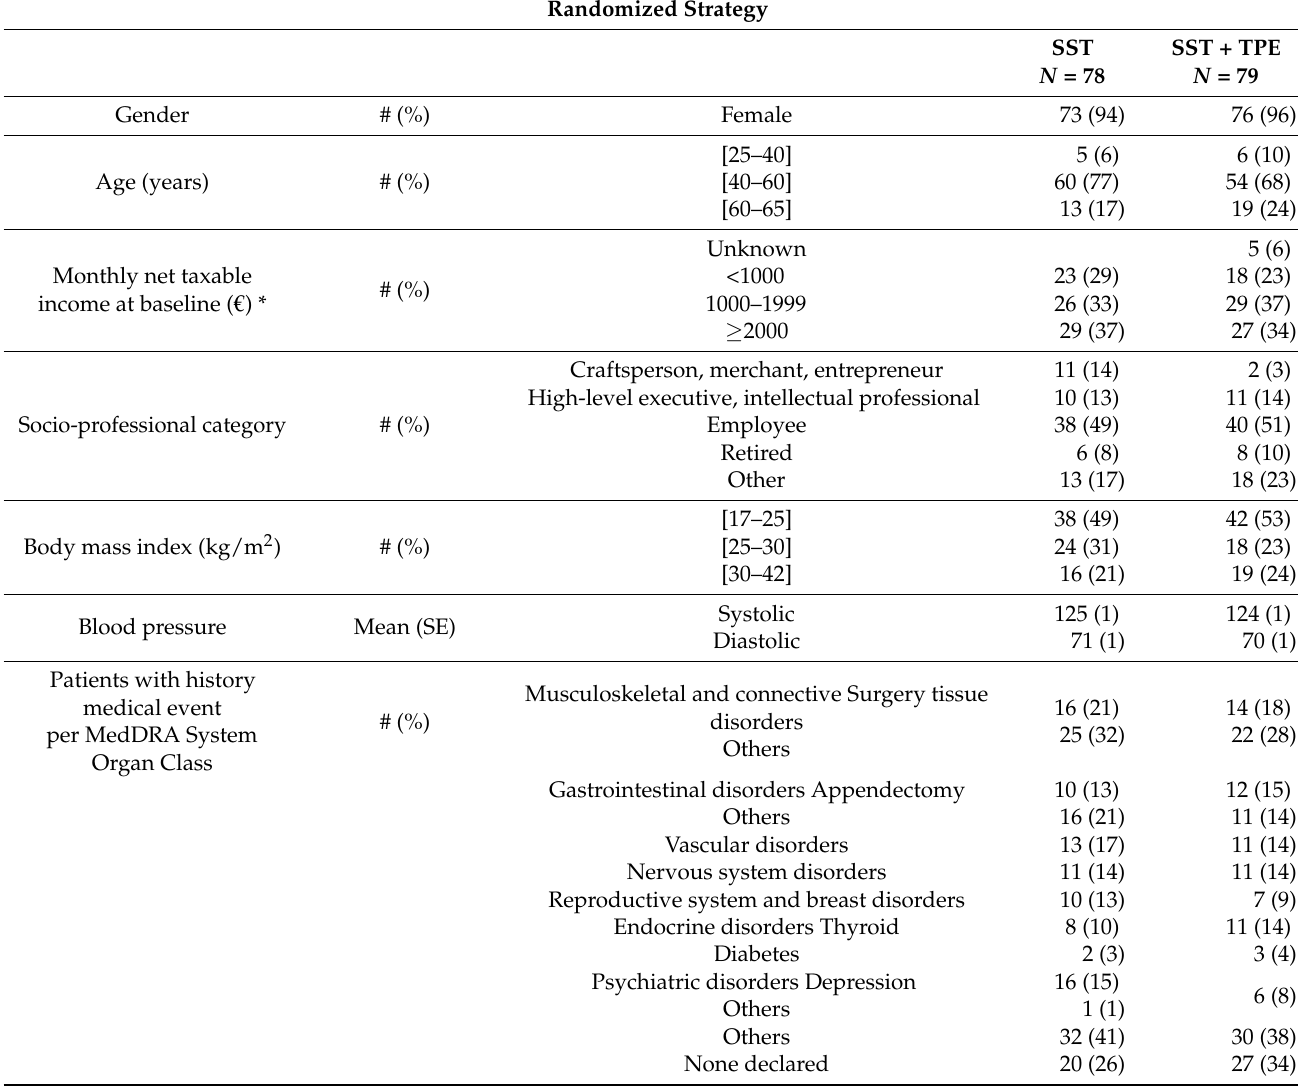
Table 1. Baseline characteristics—FiETT trial, AFRETh. Randomized Strategy